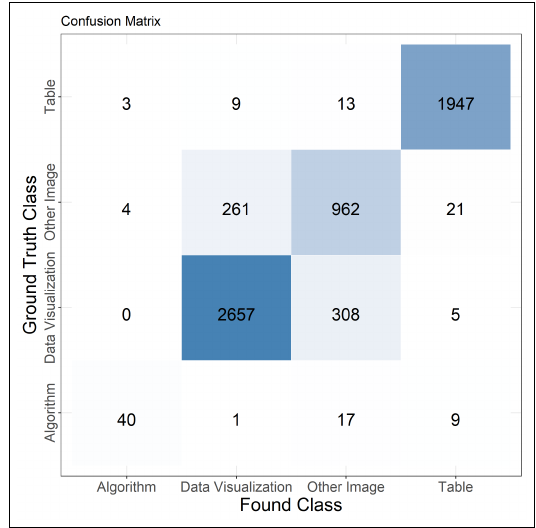
Figure 9. Confusion matrix with respect to the classification performed when detecting document elements. The overall accuracy of the classification is